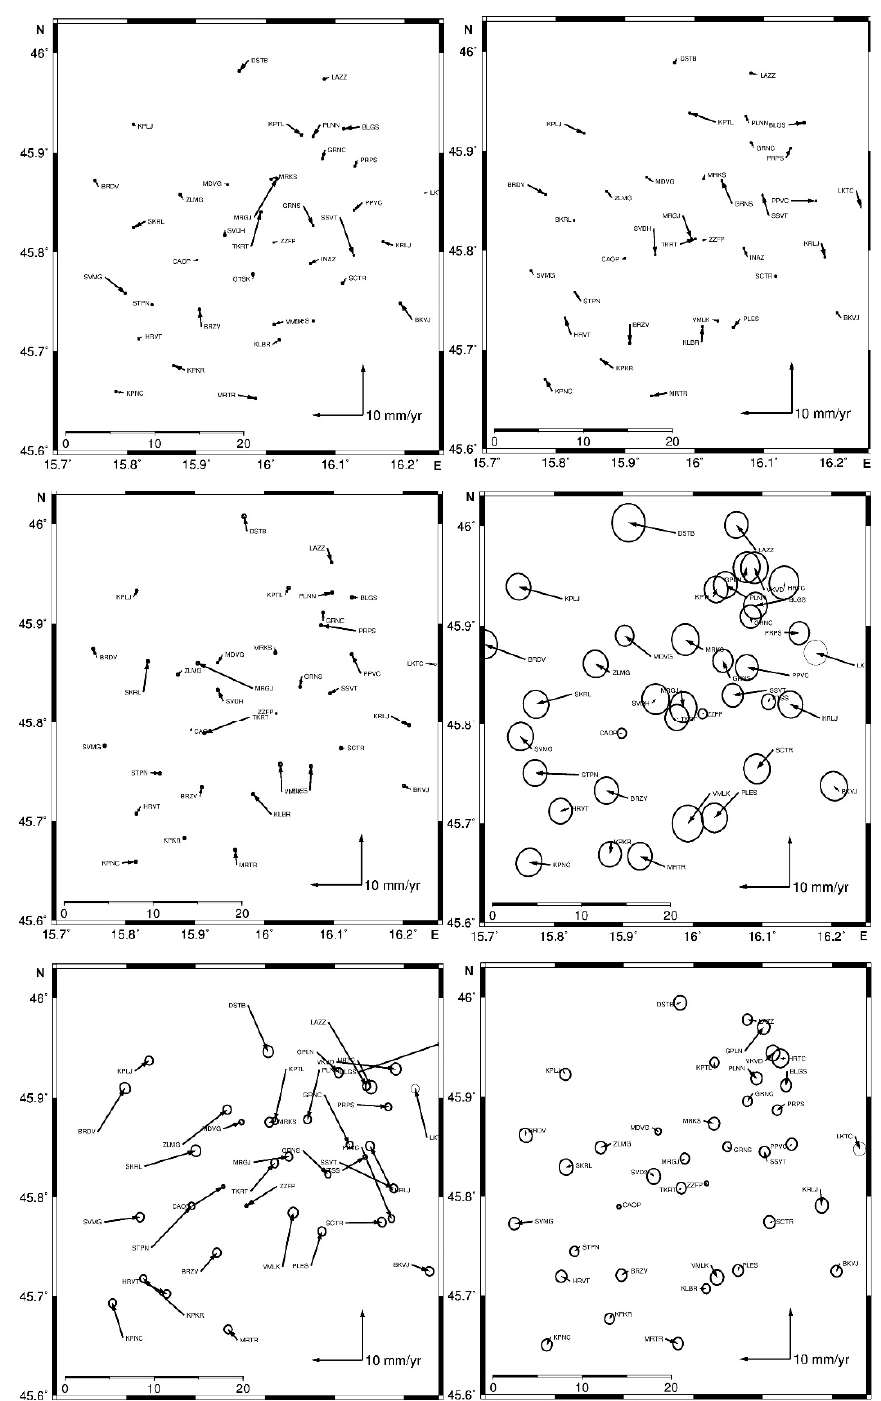
Figure 6. Velocity models for periods between epoch campaigns respectively: ‘97 ‐ ‘01, ‘01 ‐ ‘04, ‘04 ‐ ‘06, ‘06 ‐ ‘08, ‘08 ‐ ‘09, ‘09 ‐ ‘15. Formal errors scaled by 1.0, confidence interval 95%.